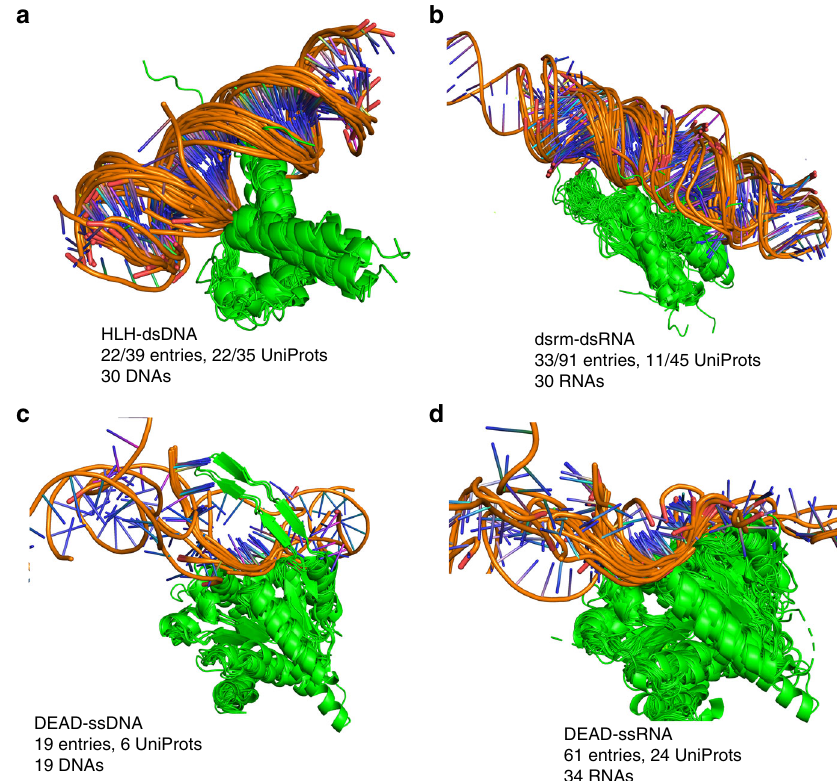
Fig. 6 Pfam – nucleic acids interactions. a The interaction of Pfam HLH domain and double-stranded DNAs contains 22 of 39 entries with HLH domains in the PDB and 22 of 35 UniProts with 30 unique DNA sequences. HLH domains are aligned based on Pfam hidden Markov model positions by pair_ fi t in PyMOL. The coordinates and PyMOL script fi les can be downloaded from http://dunbrack2.fccc.edu/ProtCiD/Results/EntityPfamArchWithPfam.aspx? PfamId = HLH web page and are included in HLH_pdb.tar.gz with other ligands or http://dunbrack2.fccc.edu/ProtCiD/IPdbfam/PfamLigands.aspx? Ligand = DNA web page and are included in DNA.tar.gz with other DNA – interacting Pfams. b . The interaction of Pfam dsrm domains and double-stranded RNAs occurs in 33 of 91 entries with the (dsrm) Pfam, and 11 of 45 UniProts. c . The interaction of Pfam DEAD domains and single-stranded DNAs contains 19 entries and 6 UniProts. d The interaction of Pfam DEAD domains and single-stranded RNAs occurs in 61 entries and 24 UniProts, interacting with 34 distinct RNA sequences. The DEAD domains of D3TI84_ANAPL [https://www.uniprot.org/uniprot/D3TI84] (PDB: 4A36 [https://doi.org/10.2210/ pdb4A36/pdb]) and DDX58_HUMAN [https://www.uniprot.org/uniprot/O95786] (9 entries) structures interact with dsRNA (not shown). Nucleic acids are colored in